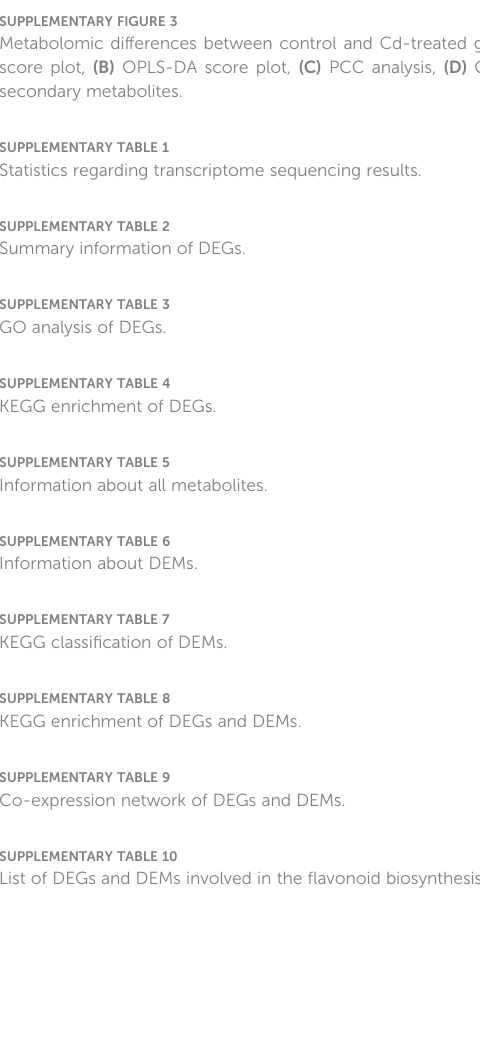
SUPPLEMENTARY FIGURE 2 Transcriptomic differences between control and Cd-treated groups. (A) PCC analysis and (B) PCA score plot.